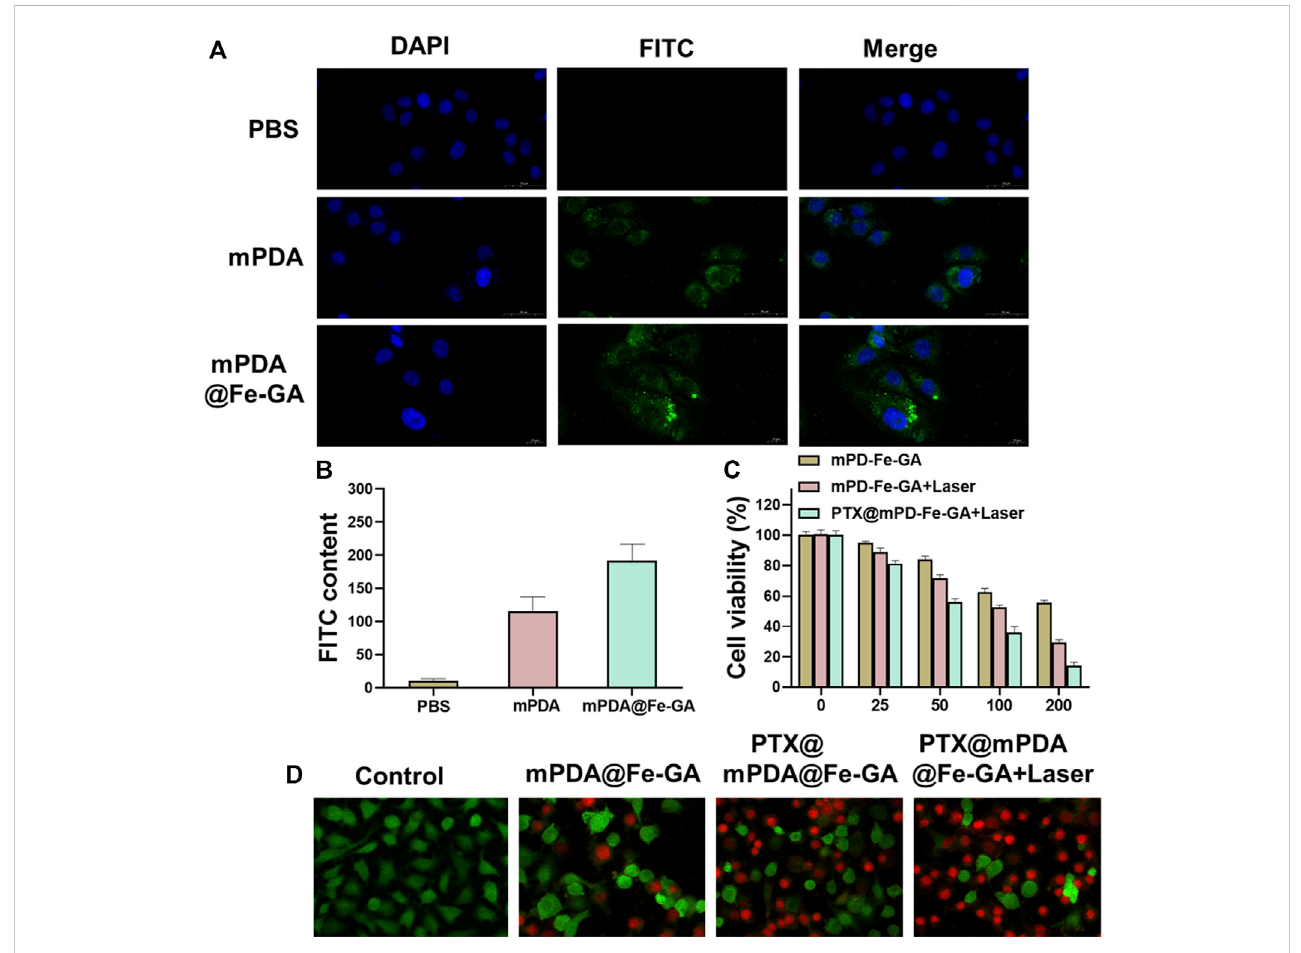
FIGURE 5 (A) CLAMwasusedtoobservetheuptakeofmPDA@Fe-GAinA549cells; (B) Semi-quantitativestatisticsofgreen fl uorescencein(A); (C) CCK-8wasused to detect cell viability; (D) Dead or alive staining of A549